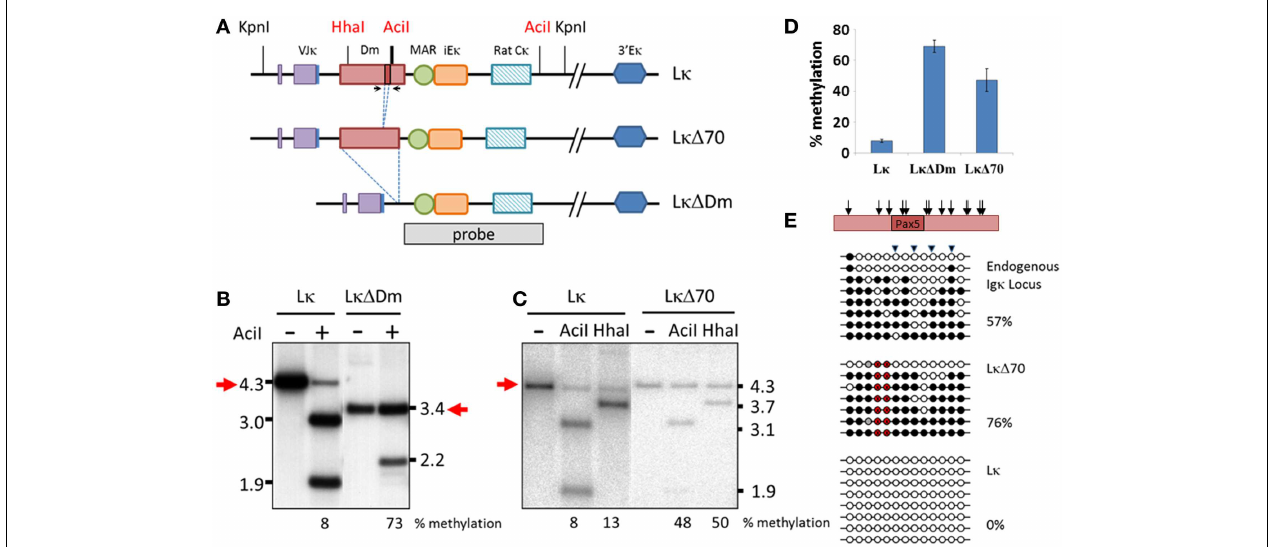
measured in DNA from two to four independent founder mice for each transgene. Error bars represent standard deviation of the methylation levels. (E) Bisulfite analysis of CpGs flanking the Pax5-binding sequence of the Dm element.Triangles mark CpGs recognized by Aci I restriction enzyme. Black circles signify methylated, white signify unmethylated, gray signify undetermined, and red signify CpGs deleted in transgene. Percentage of methylated CpGs is noted. Relative location of the CpGs within the Dm element is indicated with arrows on schematic representation of the genomic region. Location of primers is marked by arrows in (A)